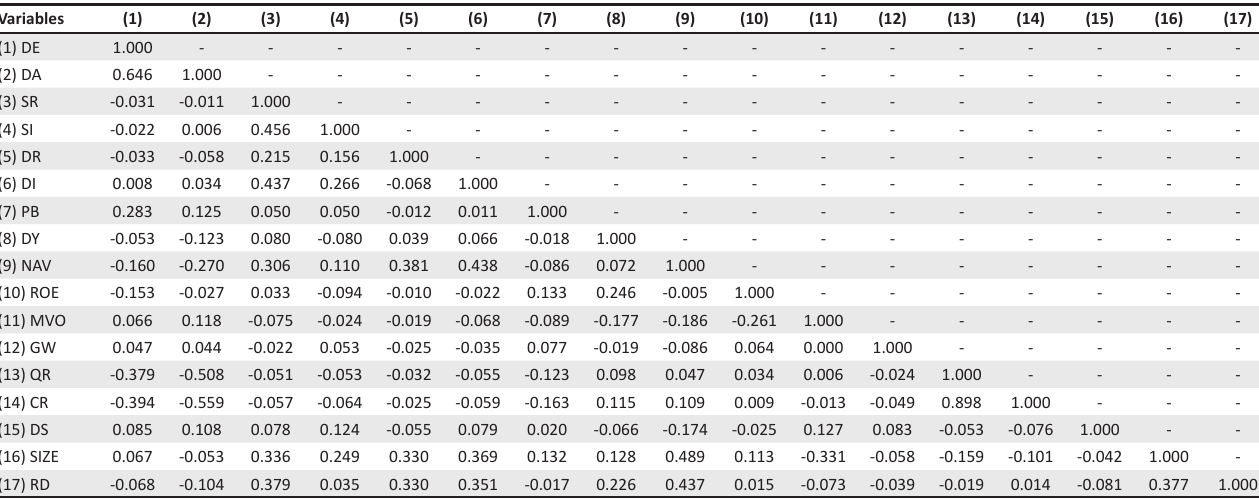
TABLE 3: Matrix of correlations.